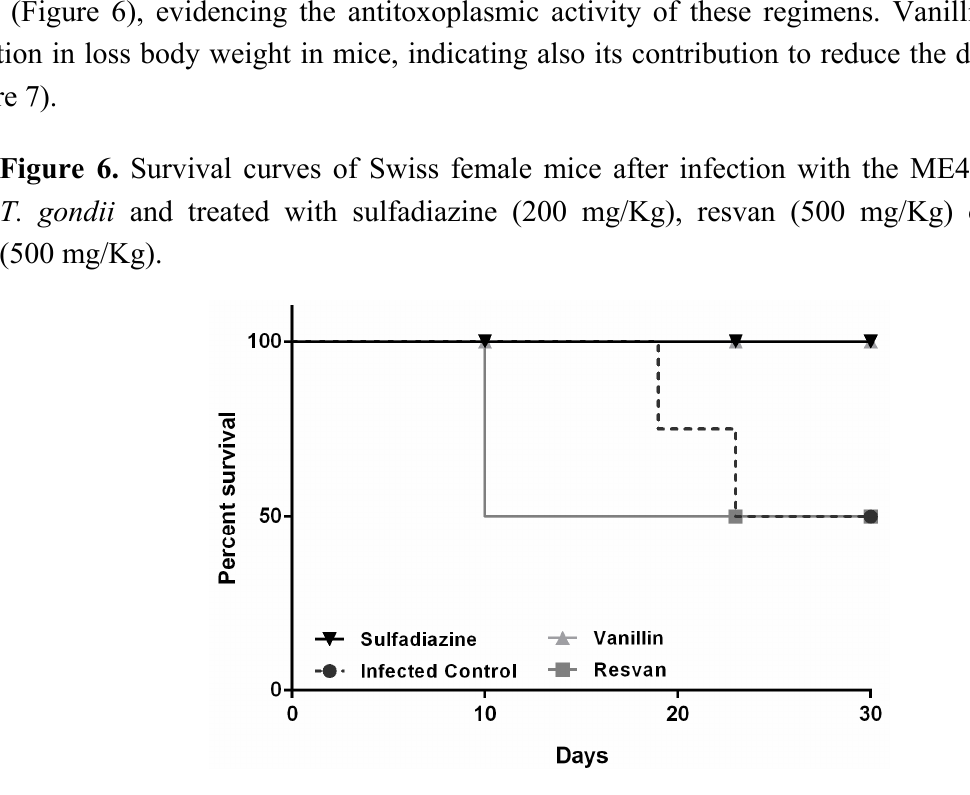
Figure 7. Change in body weight in Swiss mice infected with 25 cysts of T. gondii ME49 strain and treated with sulfadiazine (200 mg/Kg), resvan (500 mg/Kg) or vanillin (500